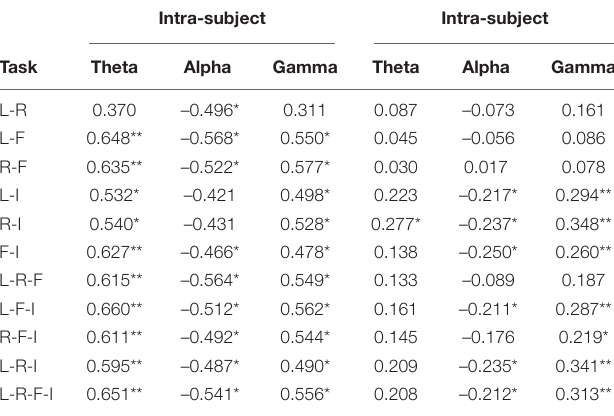
TABLE 1 | The correlation between (cid:49) RP and performance across subjects and